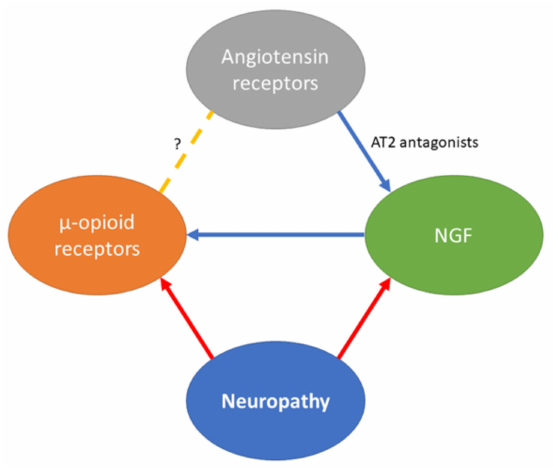
Figure 3. Possible links between neuropathy, the renin–angiotensin system, MORs and NGF. Red arrows indicate a reducing effect, while the blue ones indicate an increasing effect. In neuropathic conditions, the MOR reserve is decreased, resulting in impaired opioid analgesia. The receptor number can be restored by administration of NGF, the level of which is also reduced in the spinal cord in neuropathy. AT2 antagonists are capable of restoring the lowered NGF level, thus possibly restoring the analgesic effect of opioids. To the best of our knowledge, there is no evidence of the direct connection between MORs and the renin–angiotensin system. The figure was constructed based on literature discussed in Section